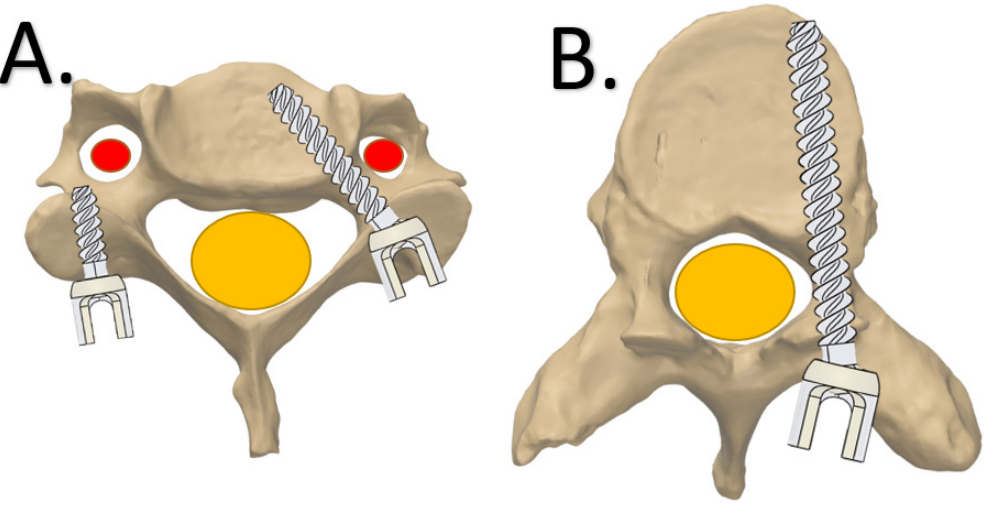
Figure 1. Screw placement in vertebrae, axial view. ( A ) Cervical vertebrae with a lateral mass screw ( left ) and pedicle screw ( right ). ( B ) Thoracic vertebrae with a right-sided pedicle screw. The red area is the cervical artery and the yellow area is the spinal cord.